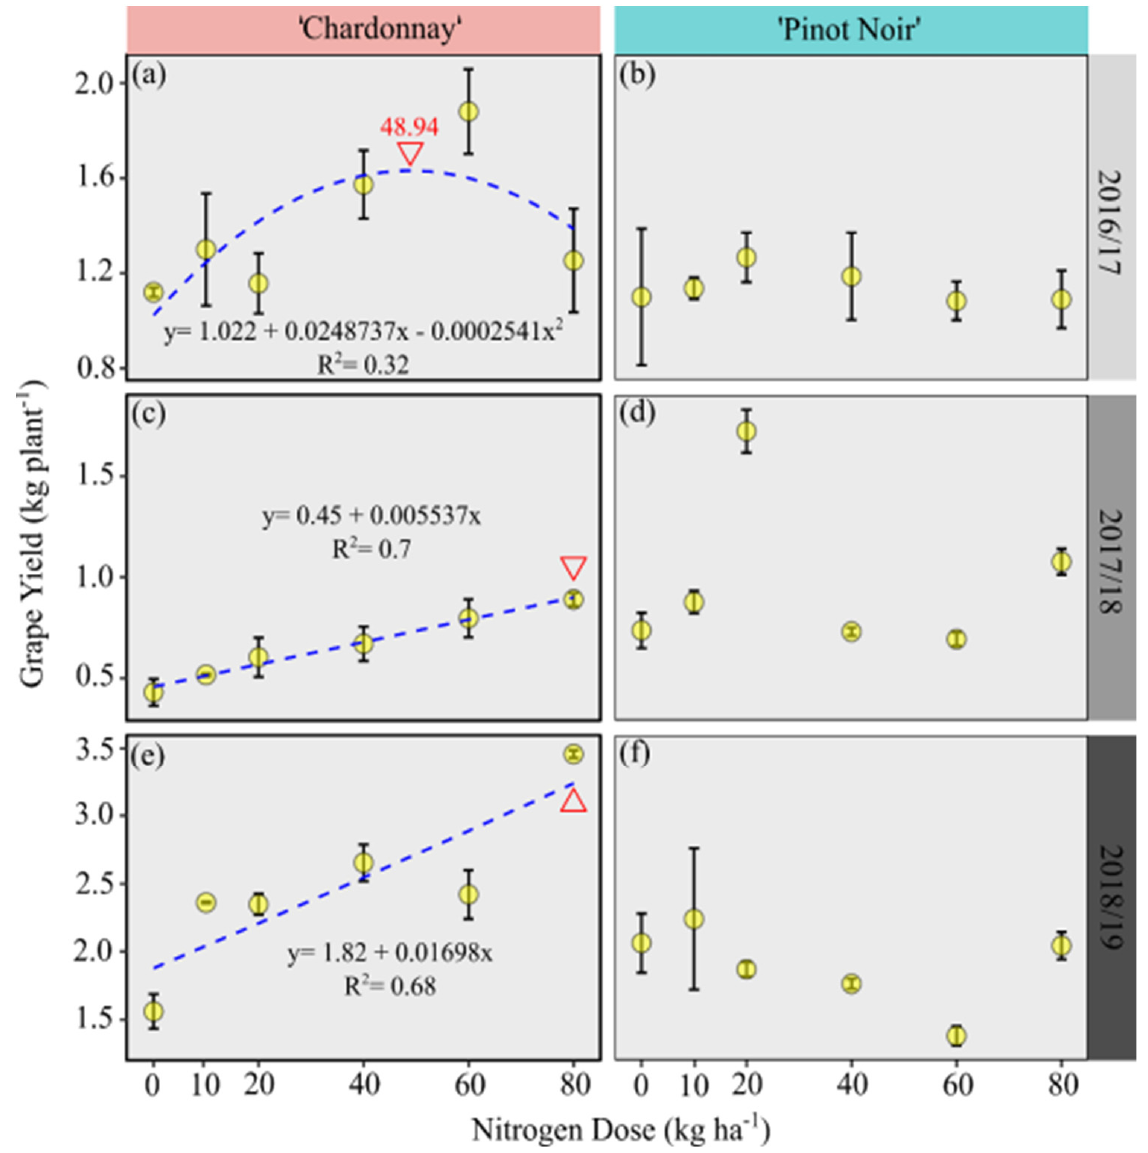
Figure 4. Maximum technical efficiency (MTE) doses of N fertilizer to ‘Chardonnay’ ( a , c , e ) and ‘Pinot Noir’ ( b , d , f ) cultivars grown in sandy soil during 2016/17, 2017/18, and 2018/19.